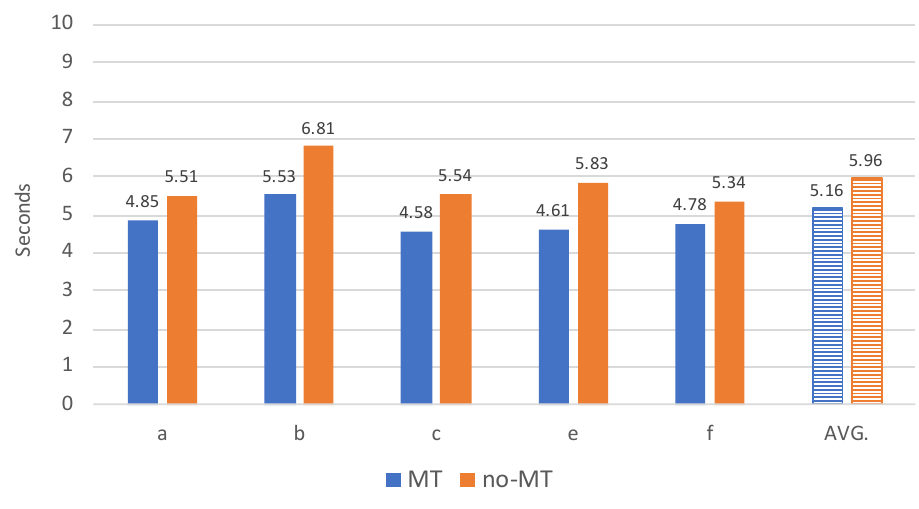
Figure 5. Average processing speed per task (expressed in seconds per source token) for five translators from the Finnish language department. ‘AVG.’ stands for the average processing speed per task for all translators of the Finnish language department.